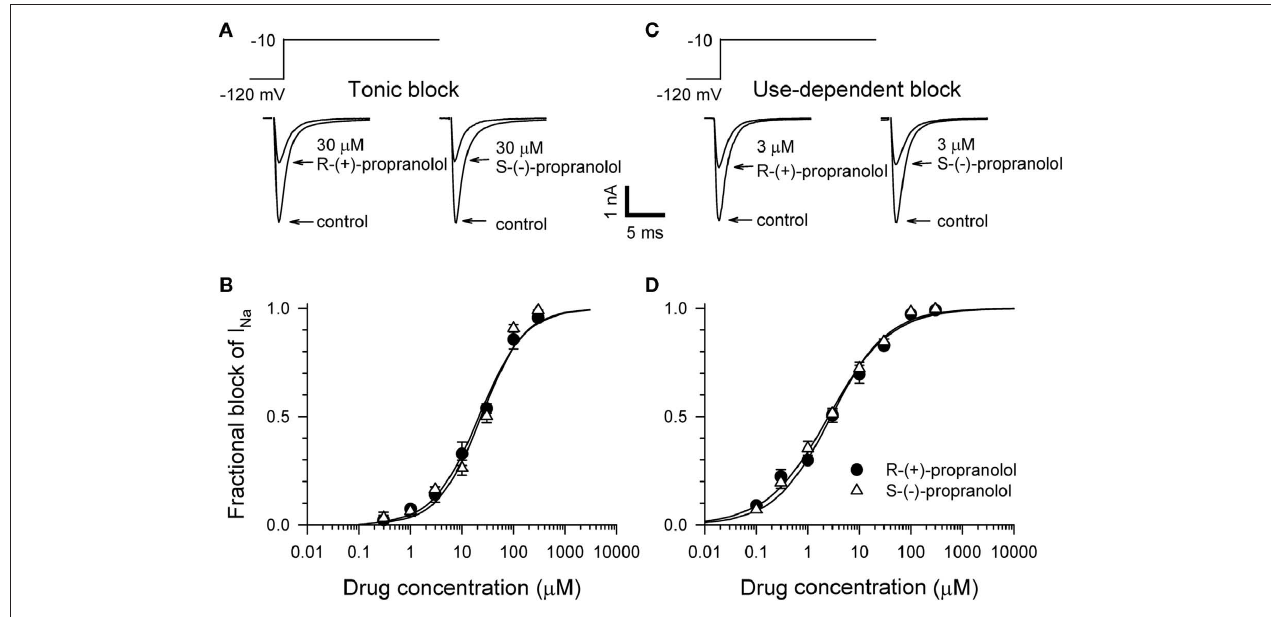
of drug illustrate the steady-state level of block achieved after 5–7 min. (B) Figure 1 | Stereoselectivity of propranolol block of Na 1.5 sodium V Concentration–response relationships for tonic block ( n = 7–14 cells per data channels. (A) Representative whole-cell voltage-clamp recordings made from point). (C) Representative traces illustrating use-dependent block by 3 μM tsA201 cells expressing Na 1.5 with the human β subunit before and after V 1 R-( + )-propranolol or S-( − )-propranolol. Use-dependent block was elicited at a application of 30 μM R-( + )-propranolol or S-( − )-propranolol. Tonic block was pulsing frequency of 1 Hz. (D) Concentration–response relationships for elicited by 100 ms depolarizations to − 10 mV from a holding potential of use-dependent block ( n = 7–14 cells per data − 120 mV delivered at a frequency of 0.2 Hz. Recordings made in the presence